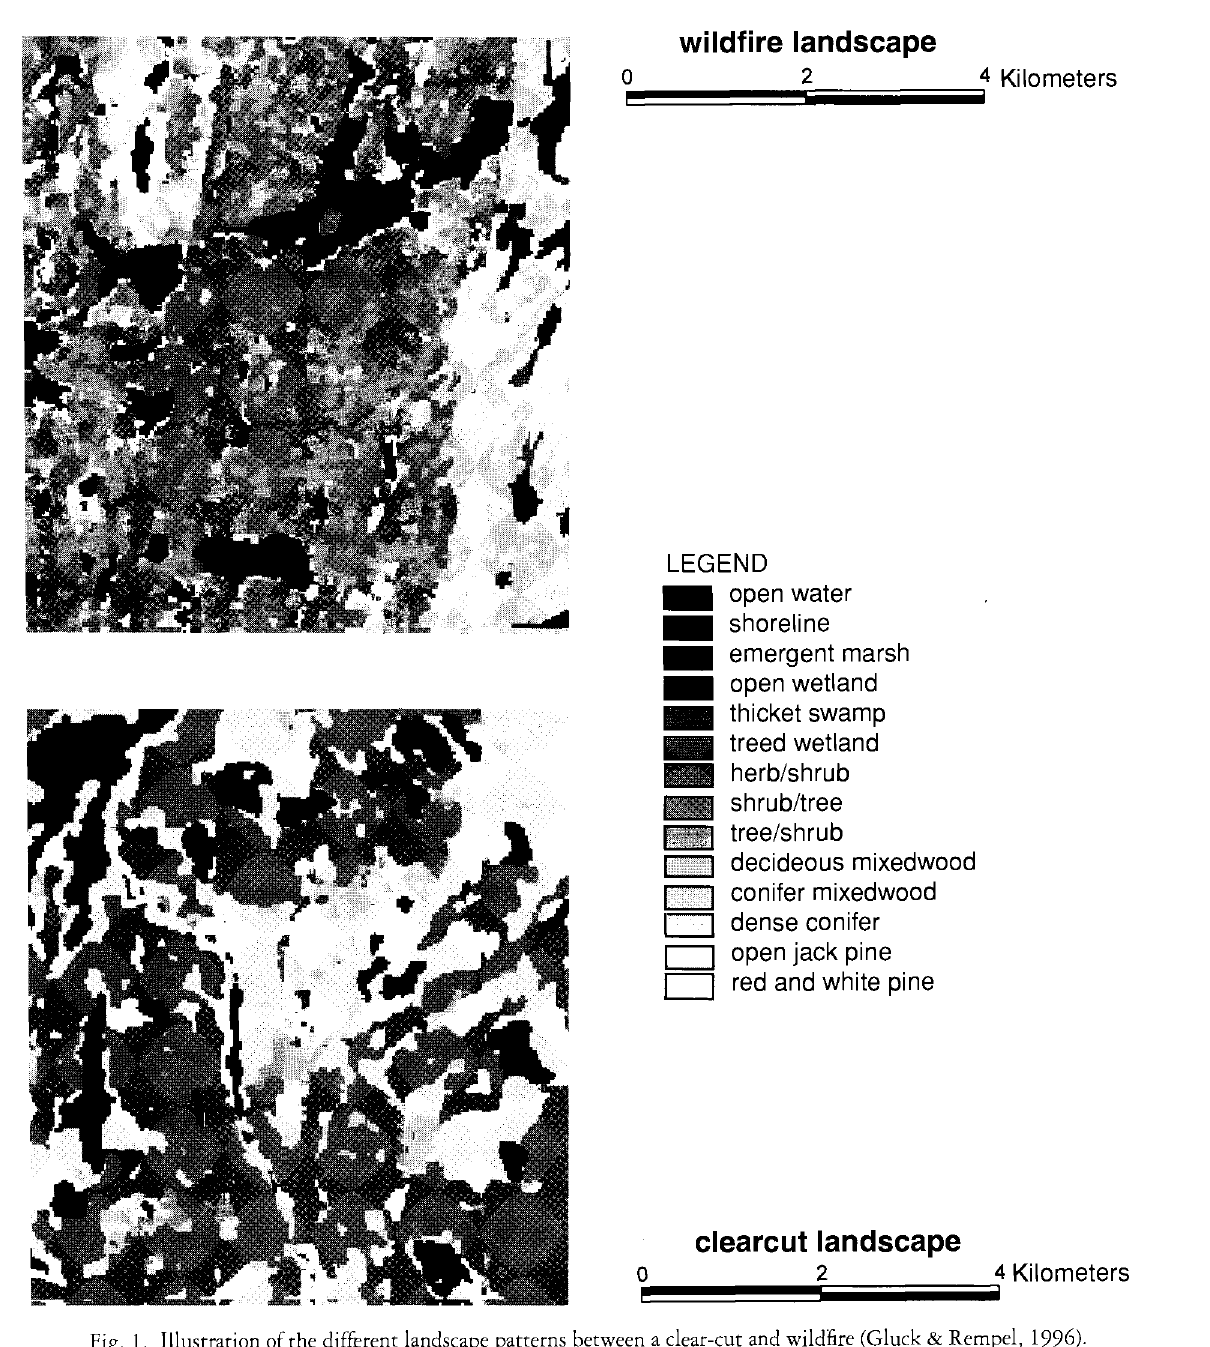
Fig. 1. Illustration of the different landscape patterns between a clear-cut and wildfire (Gluck & Rempel, 1996).